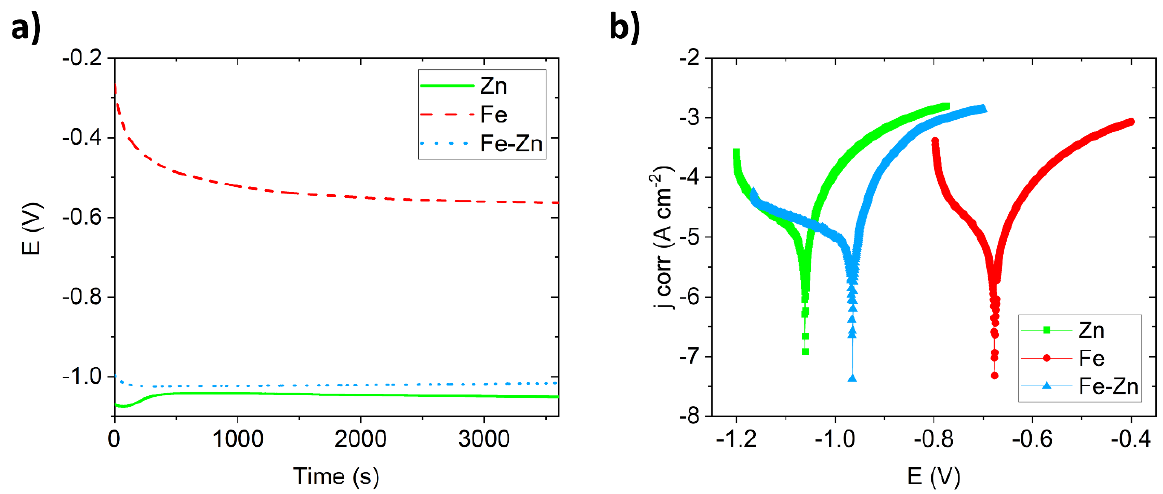
Figure 5. Determination of the open circuit potential of Zn, Fe and Fe-Zn compressed pellets in Hanks´ solution at 37 ± 2 °C was measured for 1 h ( a ). Potentiodynamic polarization curves for Zn, Fe and Fe-Zn compressed pellets measured at the same conditions ( b ).